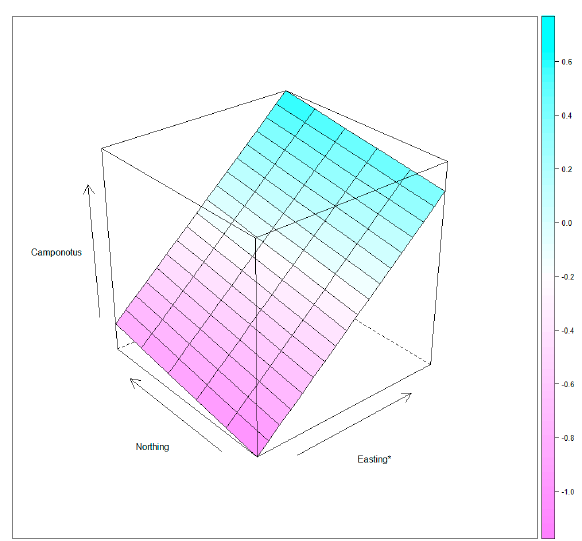
Figure 4. Influence of distribution of snapped trees on the incidence of the carpenter ant in the Czech Republic. * denotes p < 0.05.